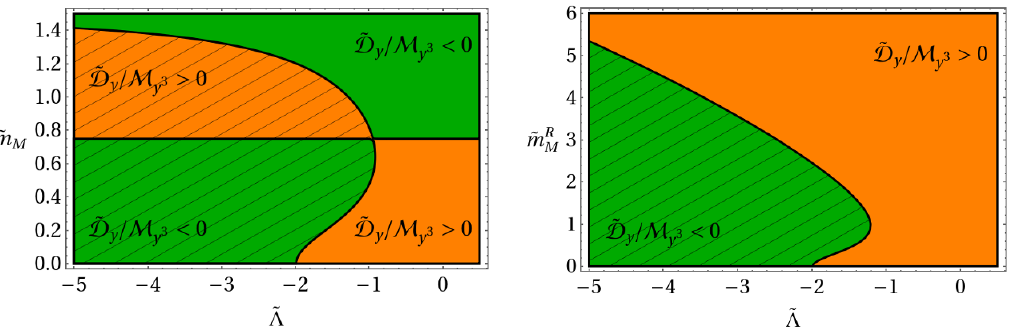
Figure 3 . Region plots showing the sign of ~ D y = M (with ~ a = ~ b = 0) in terms of ~(cid:3) and the y 3 Majorana masses. The plot on the left we consider both Majorana masses as being equal ( ~ m M := ~ m R = ~ m L ) and the plot on the right correspond to the situation where one of the masses is zero M M ( ~ m L = 0). The green (darker) region correspond to ~ D y = M < 0, while the orange (brighter) y 3 M region indicates ~ D y = M > 0. The mesh lines stand for the region constrained only by ~ D y < 0. y 3